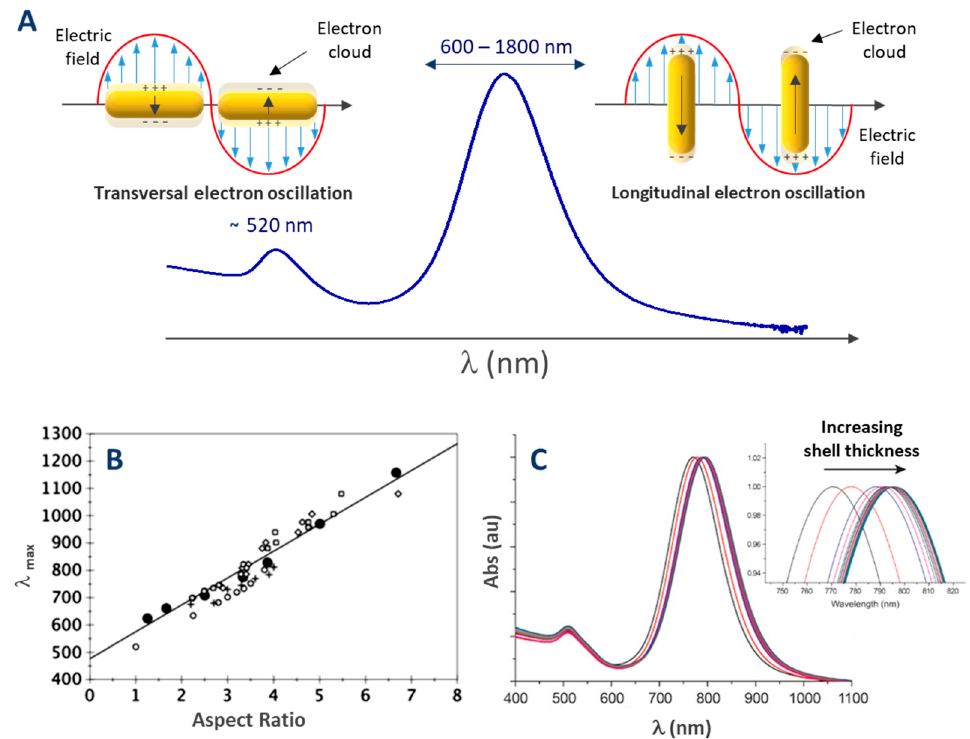
Figure 13. ( A ) Typical extinction spectrum of AuNR and the schematic representation of the electronic oscillations adapted from ref [103]. ( B ) Position of l-LSPR band maximum λ max as a function of AuNRs AR, Simulation results using the DDA (Discrete Dipole Approximation) method (black circles) [14] and experimental data from the works of Al-Sayed et al. (open circles) [104], Pérez-Juste et al. (diamonds and squares) [105] and Brioude et al. (crosses) [14]. ( C ) l-LSPR band shift with increasing silica shell thickness adapted from ref [83].